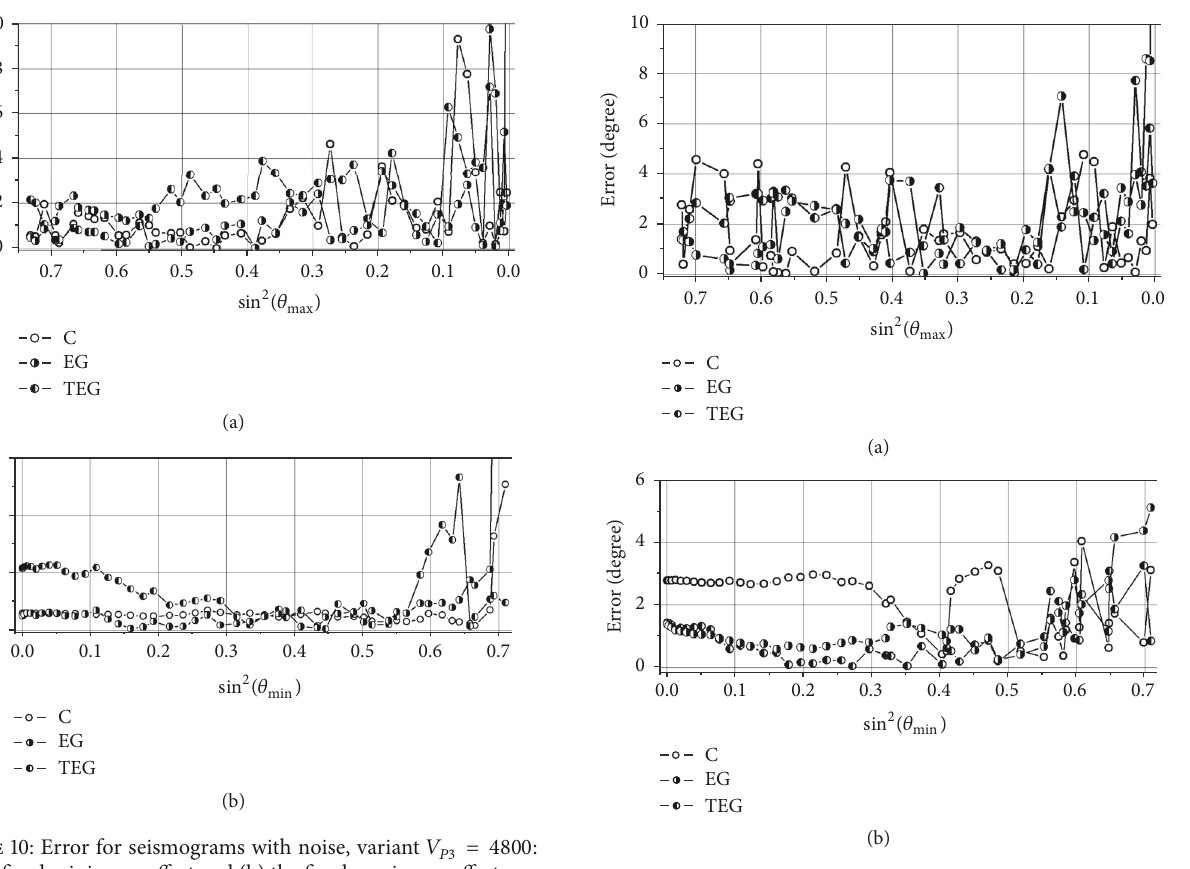
Figure 11: Error for seismograms with noise, variant 𝑉 𝑃3 = 3200 : (a) the fixed minimum offset and (b) the fixed maximum